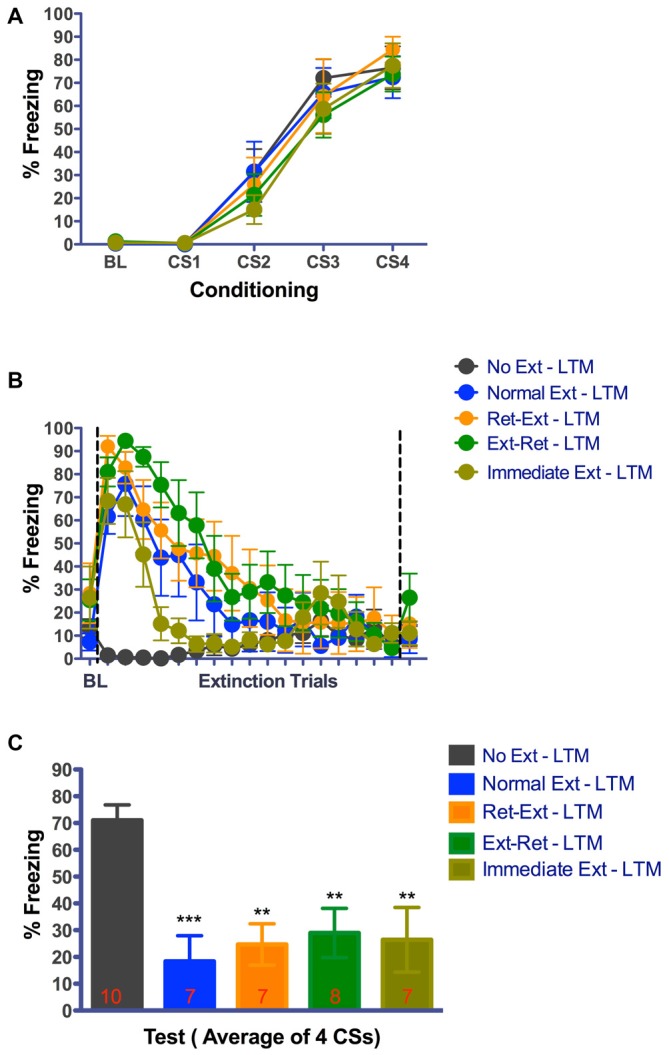
Good extinction memory 24 h after successful retrieval—extinction session. (A) Fear acquisition. Rats were fear conditioned with four tone-shock pairings on Day-1 in context A. All animals acquired cue fear. (B) Fear retrieval and extinction. Rats received retrieval and extinction procedures in context B on Day-4. Immediate extinction group was fear conditioned in Context A with four tone-shock pairings and 10 min later they received normal fear extinction session in context B. All groups showed significant within session extinction learning on Day-4. Each data point for extinction trials represent average of 3 CSs except the 17th data point that represents average of 2 CSs totaling 53 CSs. Data point after the line break represent the average of 3 retrieval CSs for Ret-Ext and Ext-Ret groups. (C) Long-term fear extinction memory test. Rats received four tone only presentations in context B 24 h after the extinction procedures. Normal Ext, Ret-Ext, Ext-Ret, Immediate Ext groups showed significant low fear memory. One-Way ANOVA with Tukey’s multiple comparison test was used for Day-4.) (**P < 0.01, ***P < 0.001 vs. No Ext). Groups: No Ext, no extinction; Normal Ext, normal extinction; Ret-Ext, retrieval first + extinction; Ext-Ret, extinction + retrieval later; Immediate Ext, Fear conditioning first + immediate extinction. To avoid any potential confounding effect of the test by itself, different groups of rats were tested in the short-term memory and 24 h memory tests.